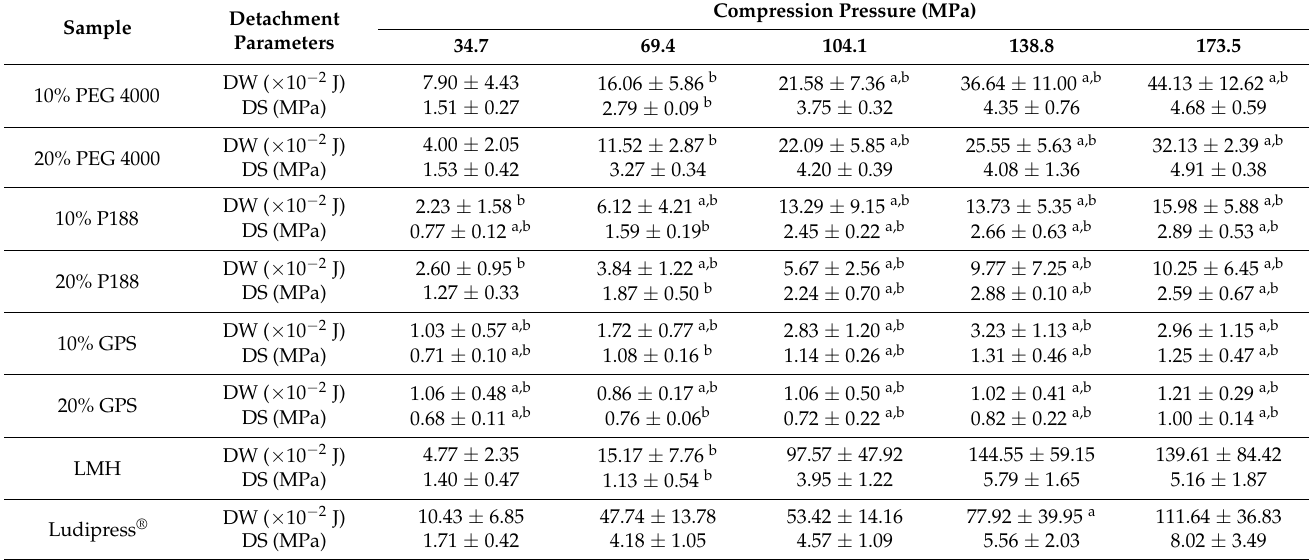
Table 3. Detachment parameters for co-processed mixtures, LMH and Ludipress ® .